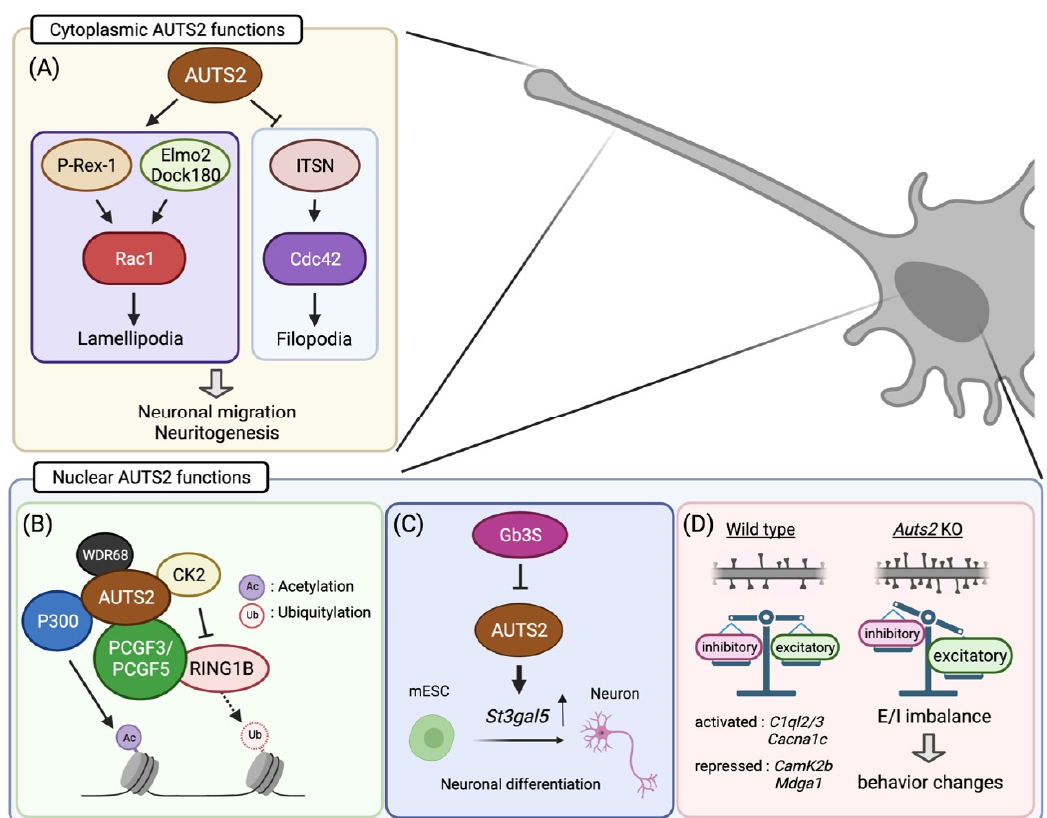
Figure 2. Summary of the molecular and cellular functions of AUTS2 in neurodevelopment: ( A ) Cytoplasmic AUTS2 activates the Rac1 signaling pathway via P-Rex1 and Elmo2/Dock180 complex, promoting neuronal migration and neurite extension. In contrast, AUTS2 inhibits Cdc42 activities to suppress filopodia formation. ( B – D ) In cell nuclei, AUTS2 acti- vates gene transcription through histone modification by interacting with the PRC1 complex ( B ). AUTS2 represses the monoubiquitylation activity of RING1B by recruiting CK2 while promoting histone acetylation via P300. ( C ) AUTS2 con- trols neuronal differentiation from mouse embryonic stem cells (mESCs) through transcriptional activation of the sphin- golipid-producing enzyme gene, St3gal5 . In mESC, AUTS2 expression is repressed by globo-series glycosphingolipids generated from Gb3 synthase, Gb3S. ( D ) AUTS2 modulates the E/I balance by limiting the number of excitatory synapses. Loss of Auts2 leads to increased dendritic spine formation, disturbing the E/I balance within neural circuits. AUTS2 regu- lates the expression of the gene related to synapse development and functions. Moreover, Auts2 mutant mice display behavioral abnormalities in social interaction, vocal communication, cognition, and motor skills. Illustration created with BioRender.com.